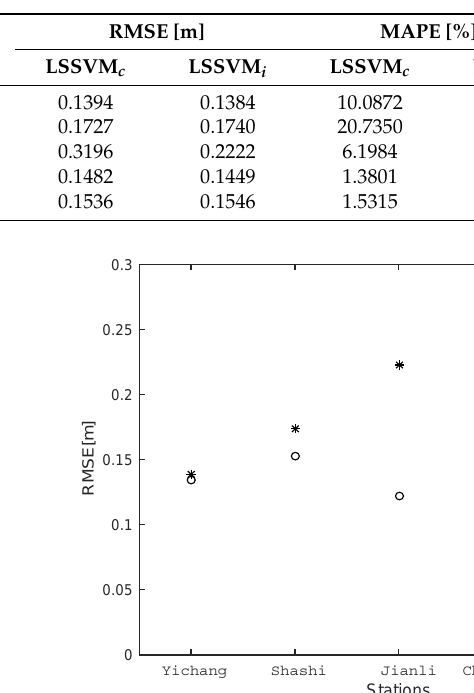
Table 2. Computation results of RMSE, MAPE and d for LSSVM c and LSSVM i .